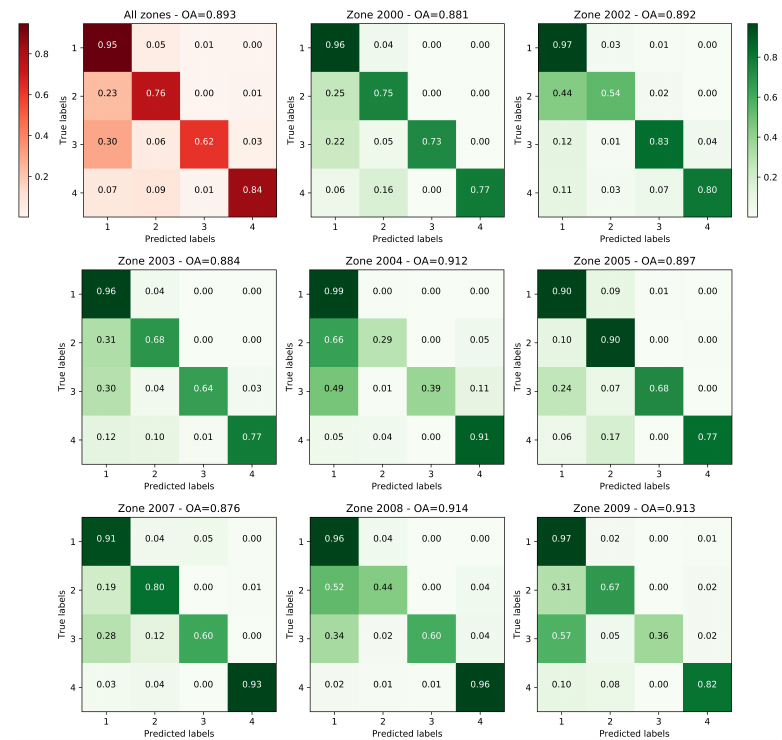
Figure 11. Normalized confusion matrices for the point-base validation of the RF riverscape units map, zone by zone and global assessment. Corresponding class codes are reported in Table 3.